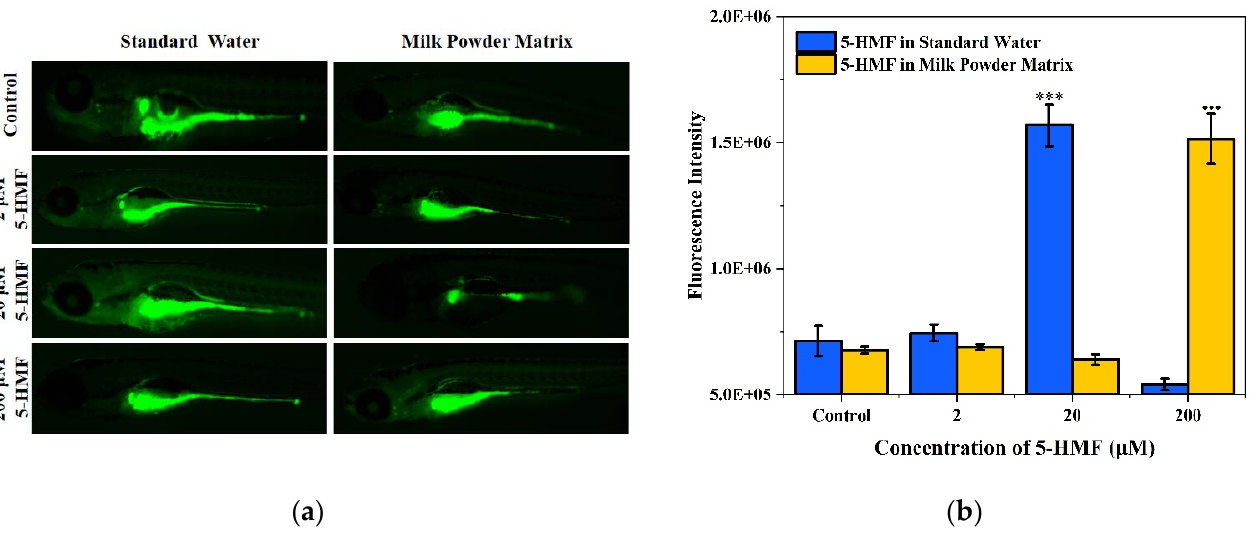
Figure 5. Induction of ROS production by medium and high concentrations of 5-HMF in different matrices. ( a ) Imaging of ROS staining in zebrafish larvae in different matrices; ( b ) Fluorescence intensity of zebrafish larvae ROS in different matrices. *** or ••• p < 0.001 vs. control.